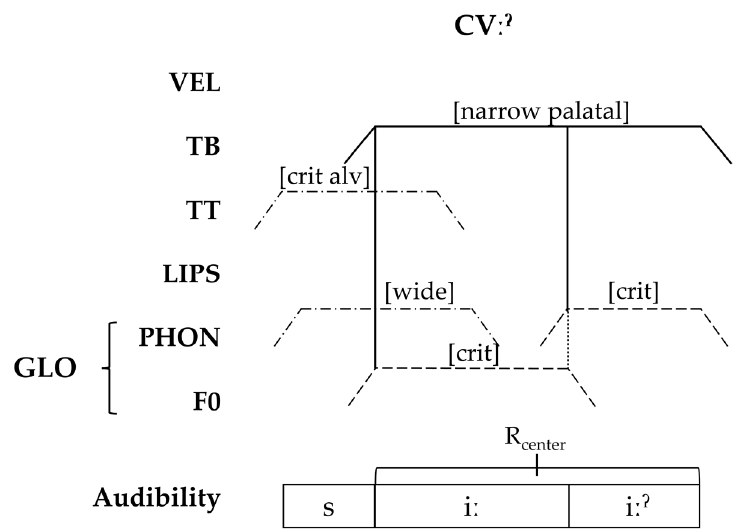
Figure 16. The phonetic realization of stød onset in CV ːˀ words, such as [si ːˀ ] ‘sieve.’ Note that stød begins late relative to the sonorant rhyme center, possibly for perceptual reasons.